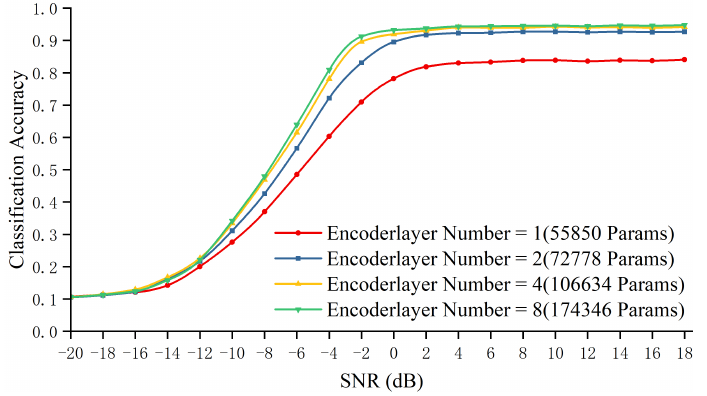
Figure 15. Classification accuracy vs. SNRs for TMRN-GLU with different number of Encoder